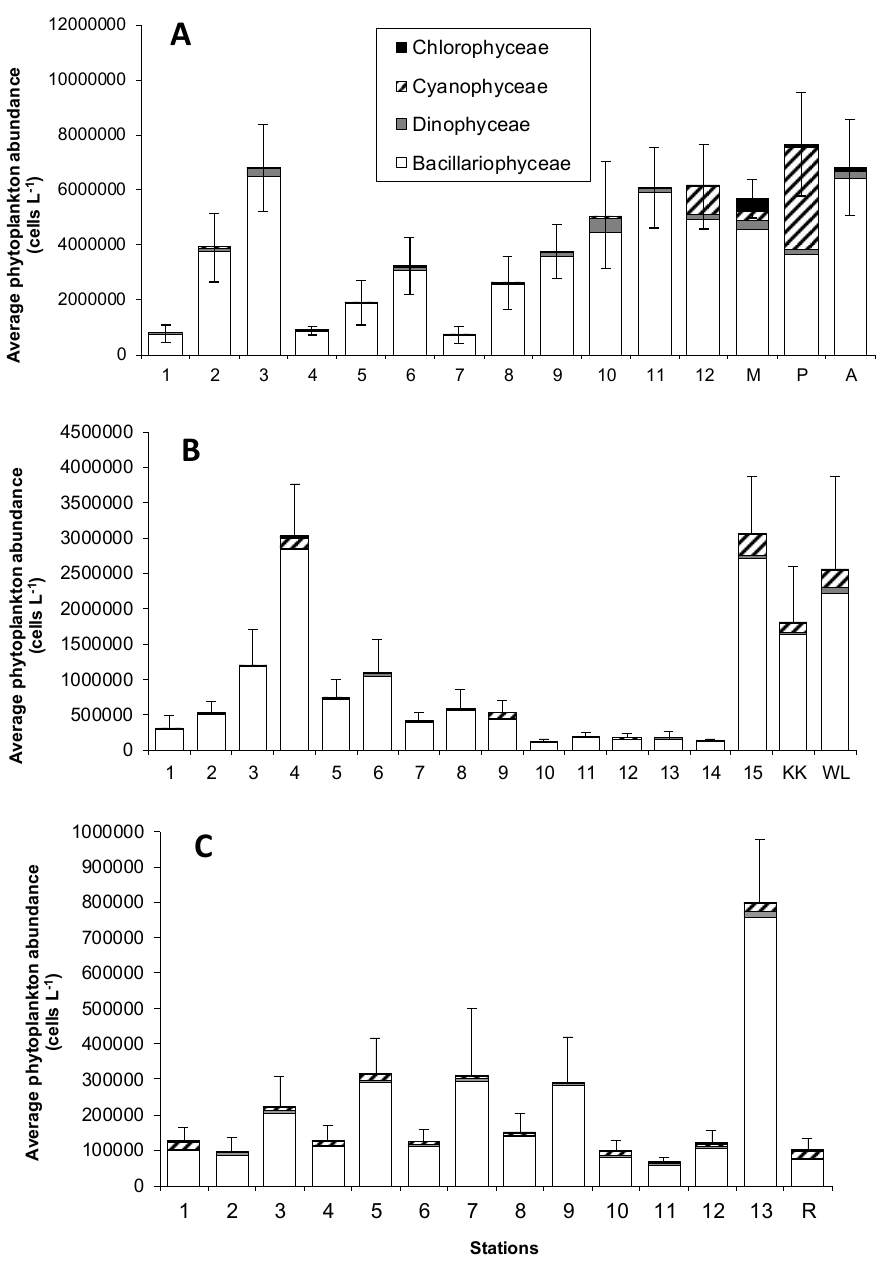
Figure 6. Phytoplankton cell abundance (cells L − 1 ) of each station in Jakarta Bay ( A ), Lampung Bay ( B ), and Semangka Bay ( C ). Redrawn from Damar et al. [23]. Algae pigment analysis of Lampung Bay shows that the pigments were composed by Chl-a, Chl-b, Chl-c, peridinin, zeaxanthin, diadinoxanthin, lutein, fucoxanthin, and ß-carotene. High total pigment concentrations prevailed at river mouths and at the surrounding sites (stations 4 and 15), while at other stations that were located in the more o ff shore waters, the pigment concentration was low. At all stations, except river mouths, fucoxanthin and diadinoxanthin dominated the phytoplankton pigments, indicating the dominance of diatoms. At river mouths, Chl-b was the dominant pigment, a marker of Chlorophyceae from the genus of Scenedesmus. Chl-c as a biomarker for dinoflagellates was found at almost all sites, but in rather low